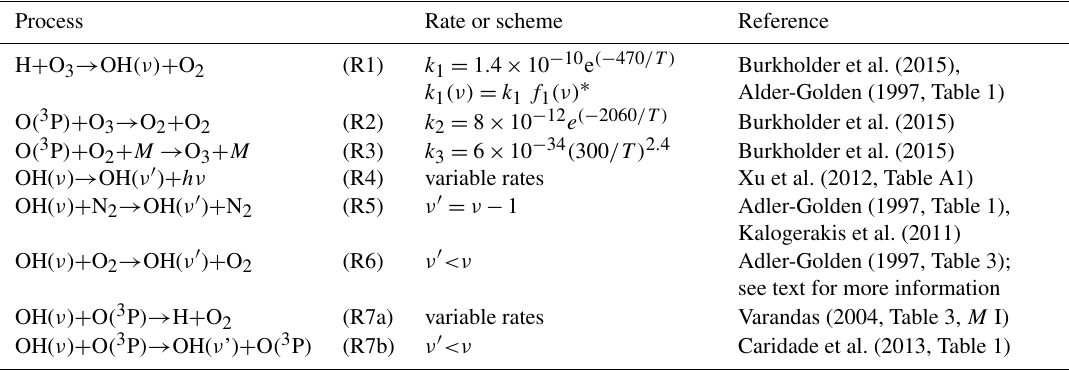
Table 1. Physical processes and chemical reactions included in the base model. Process Rate or scheme